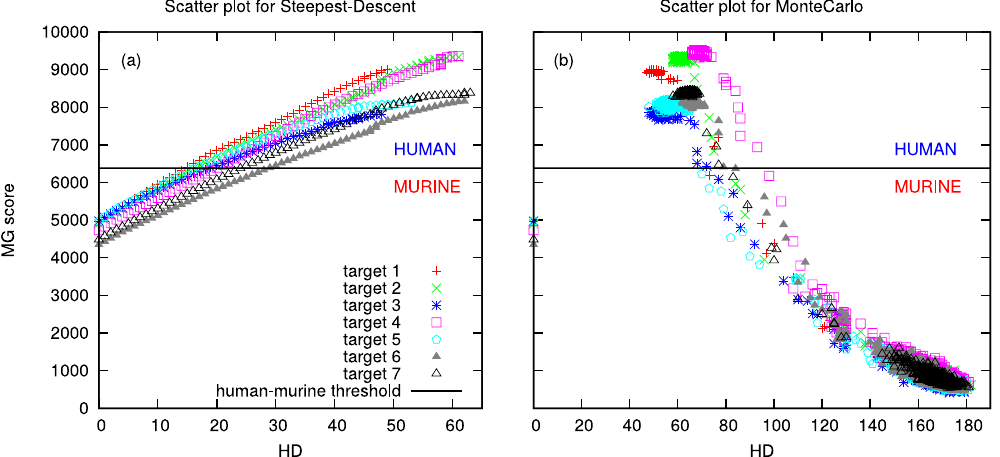
Figure 4. Scatter MG score-Hamming distance plot for the Steepest Descent (Panel (a)) and the SAMC (Panel (b)) for all our targets. Here HD is the Hamming distance between our proposed sequence and the original murine one. The SAMC trajectories start at the murine sequences, on the left (HD = 0, MG-score around 4500), then jump immediately to the region at the bottom-right of high HD, low score (highly non-human sequences, but very different from the original murine). Notice that all trajectories roughly overlap in this region: there is no memory of their different, and fixed, CDR sequences, and we witness a basically free exploration of the sequence space. Then, when the temperature falls below a certain threshold, the trajectories move to the top- left region, of highly human sequences with score and HD depending on the fixed CDR regions of the original sequence.